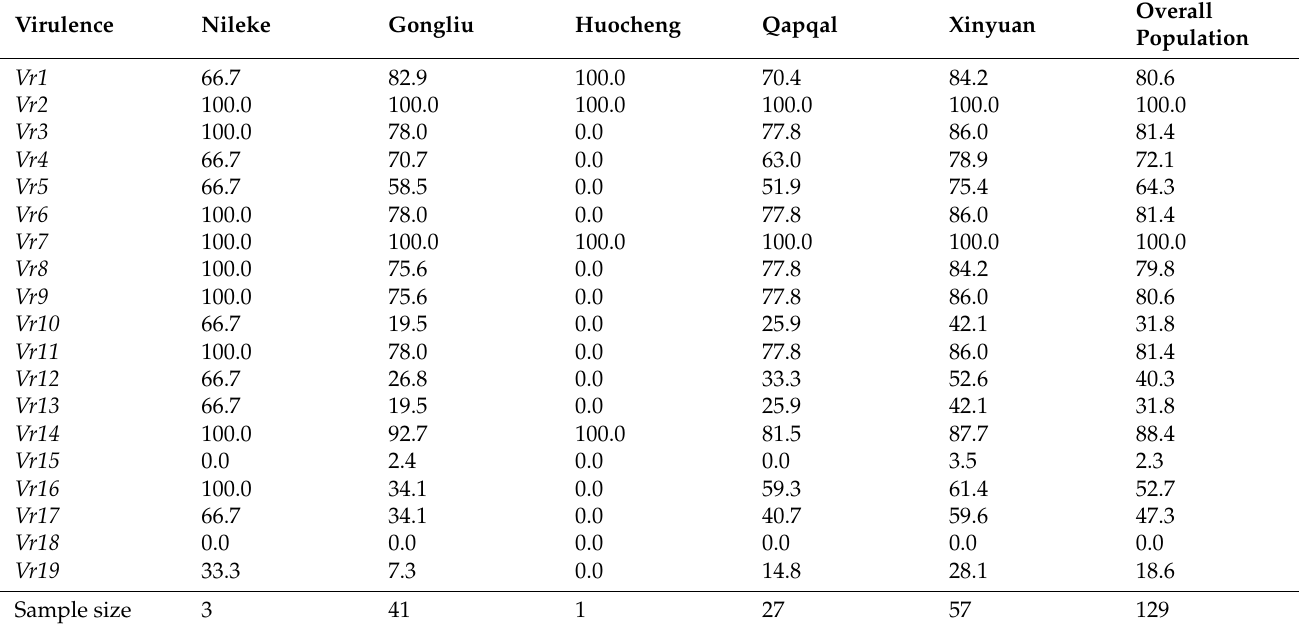
Table 2. Frequencies (%) of virulence factors in Puccinia striiformis f. sp. tritici isolates collected from